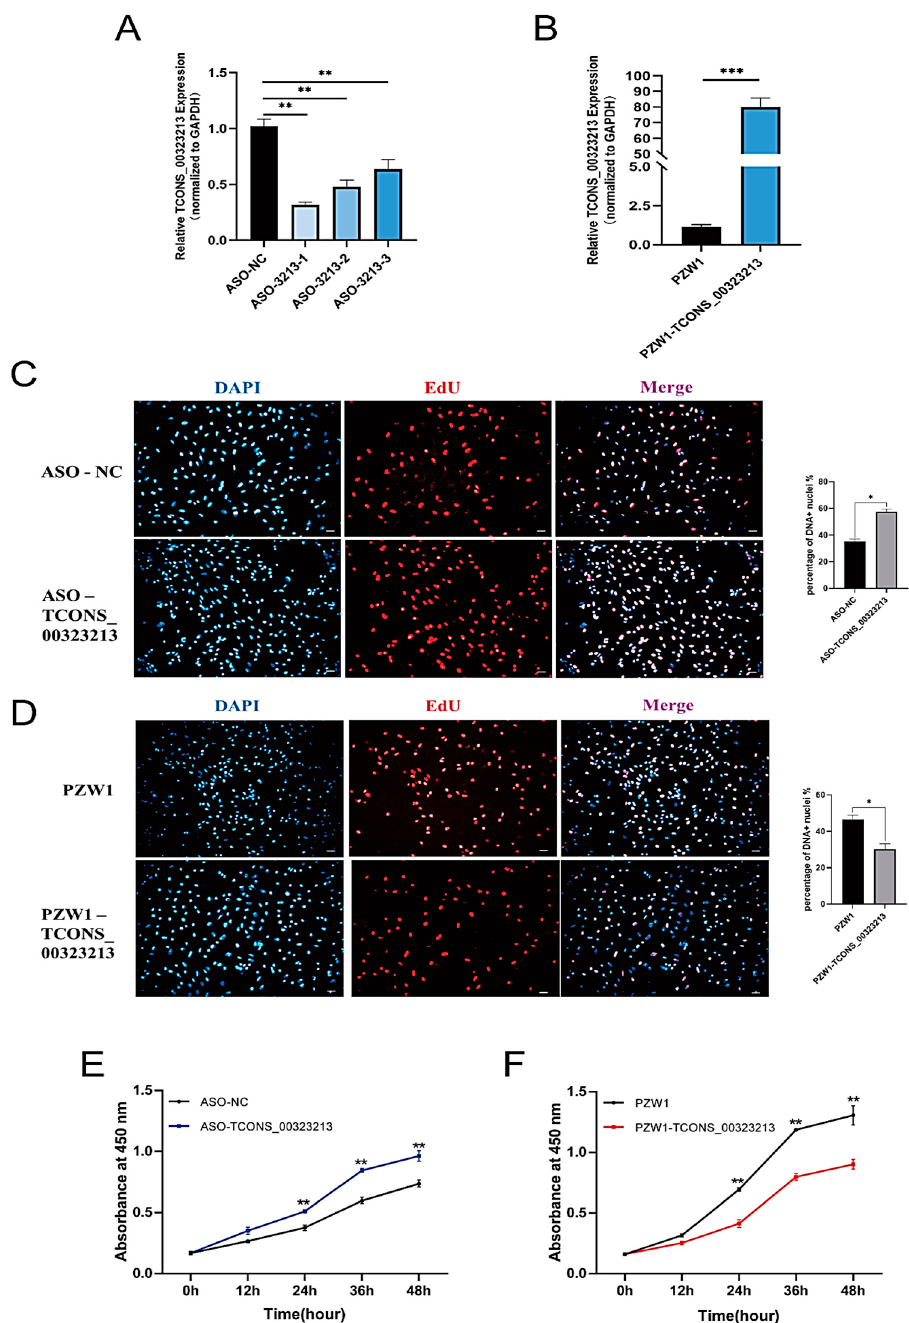
Figure 1. LncRNA TCONS_00323213 inhibits myoblast proliferation. ( A ) TCONS_00323213 knock- down e ffi ciency detection. ( B ) TCONS_00323213 overexpression e ffi ciency detection. The